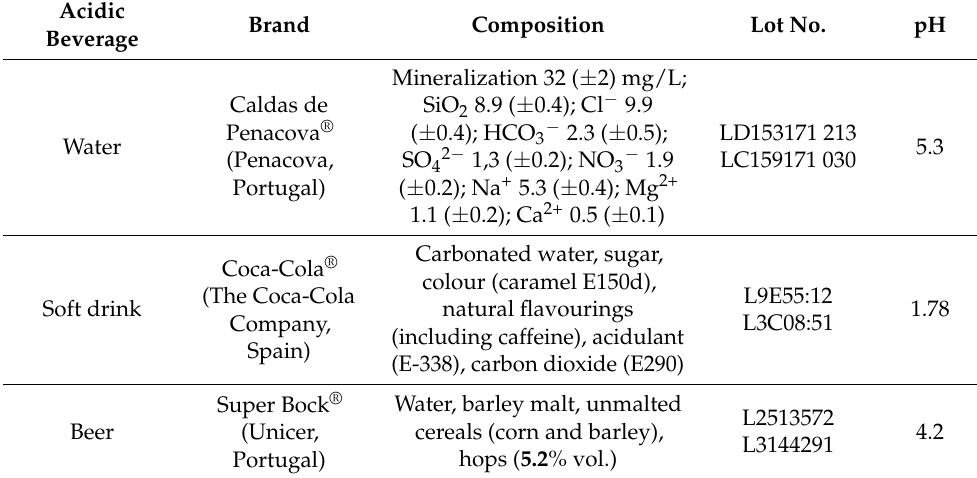
Table 2. Beverages used for immersion of composite resin and glass ionomer